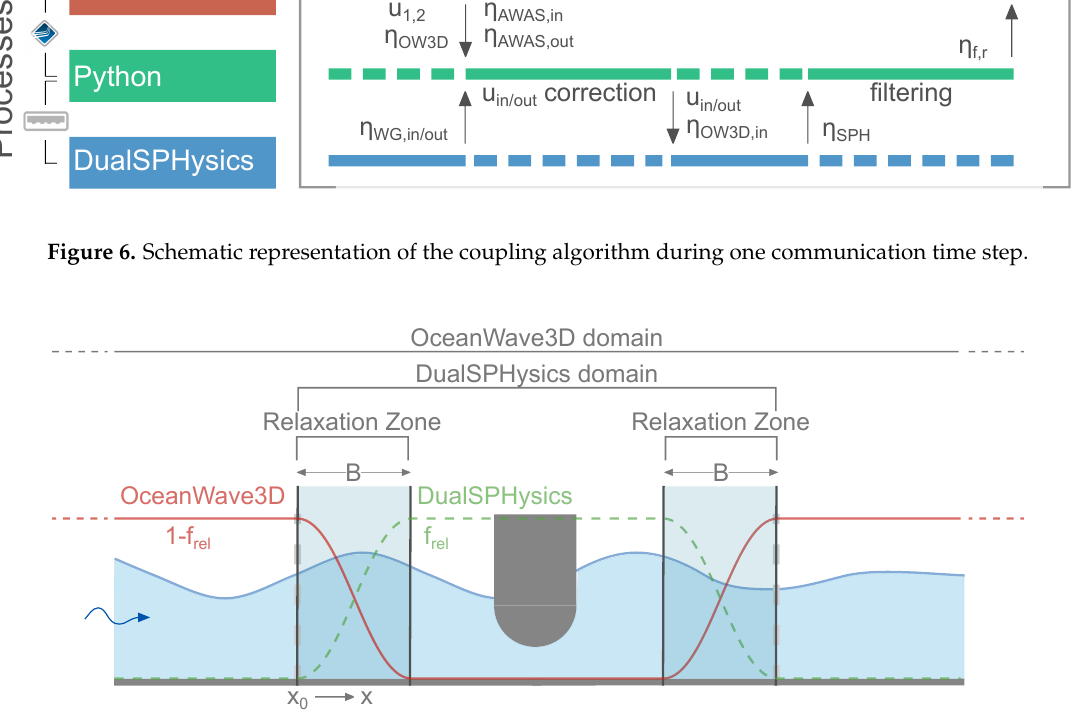
Figure 7. Sketch of ’relaxation zones’ providing a smooth transition between the OceanWave3D domain and the DualSPHysics